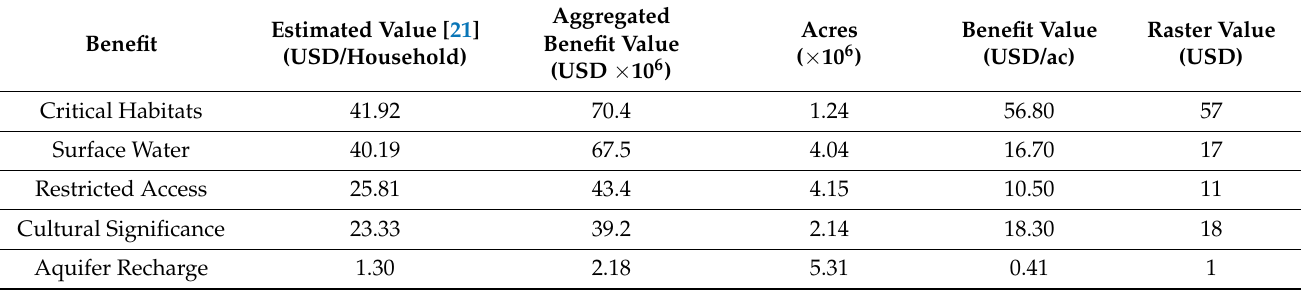
Table 1. Values calculated for dollar-per-acre benefit value estimates. The acre is the customary unit used to describe land area by US agencies and is the land unit used in this analysis. One acre of land equals approximately 4047 m 2